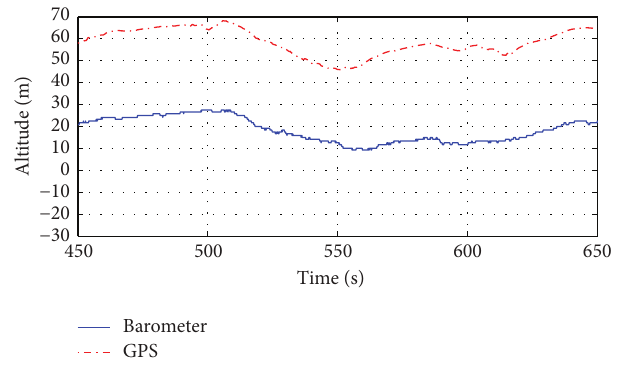
Figure 19: Flight test altitude profile.